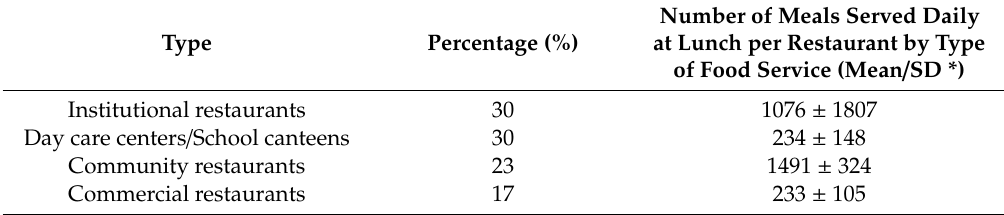
Table 1. Characterization of the Food Services of the study ( n =